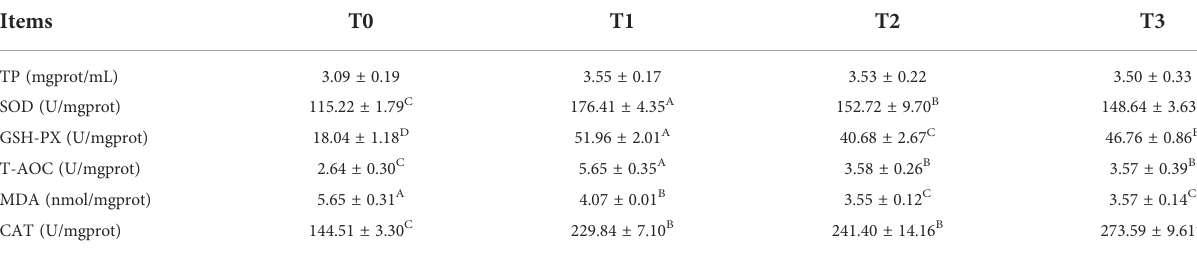
Different letters indicate signi fi cant differences (P< 0.05); Values are presented asmean ± SD (n =5); TP, total protein; SOD, superoxide dismutase; CAT, catalase; MDA, malondialdehyde; T-AOC, total antioxidant capacity; GSH-PX, glutathione